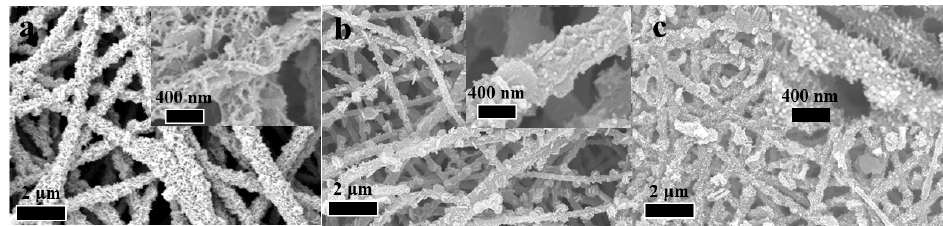
Figure 3. SEM pictures of CNFs@Ni(OH) 2 /NiO-X (200 ( a ), 250 ( b ) and 300 ( c )).